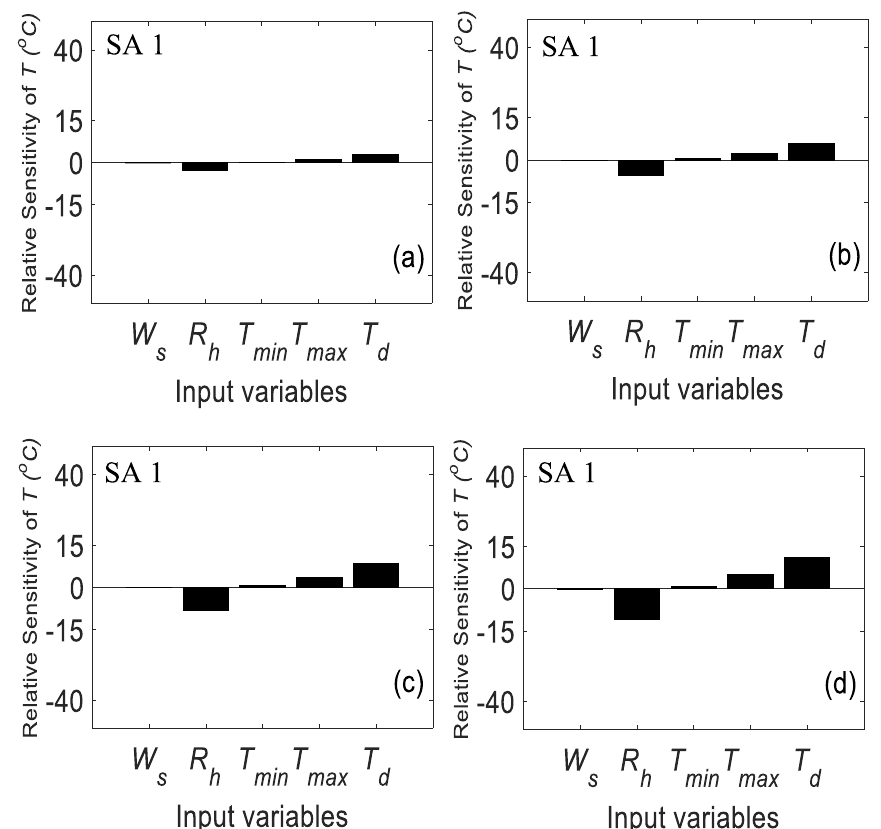
Fig. 13 Sensitivity analysis chart for configuration scenario